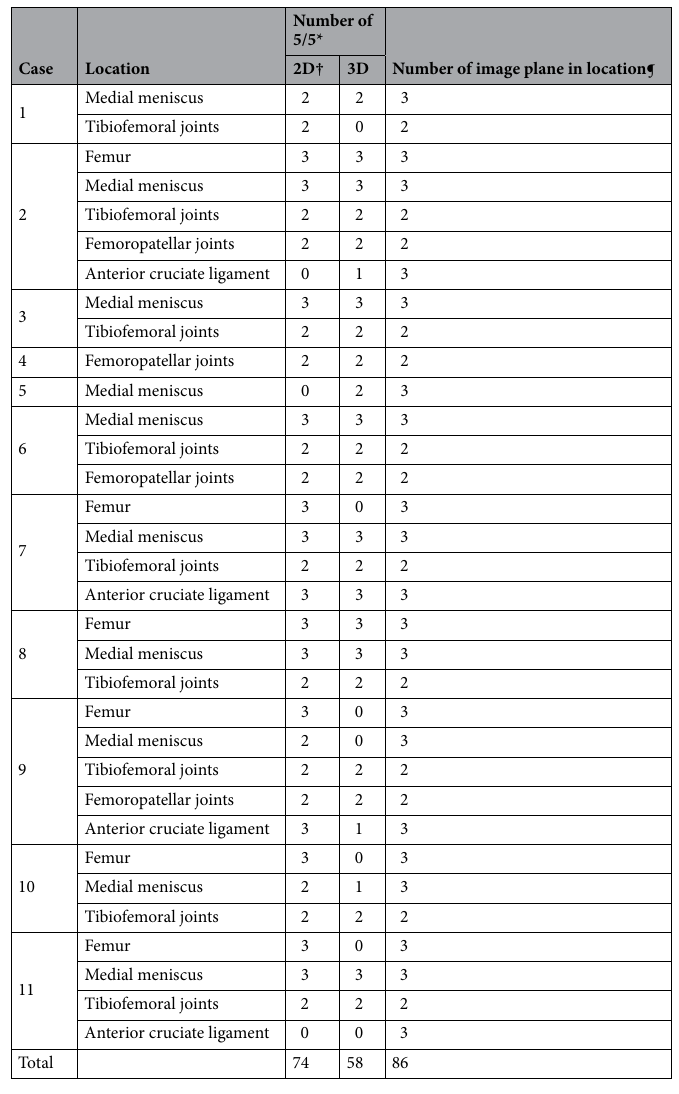
Table 5. Agreement with high confidence in “abnormal finding”. "Abnormal findings" were defined as "on both thin-slice 2D FS-PDWI and 3D FS-PD MPV images", " on two or more image planes (coronal image only for medial and lateral collateral ligament)", and “scored 4 or higher by two readers”. *5/5 indicates that two readers gave a score of 5. ¶ This represents the number of image plane defined to evaluate the abnormal findings of each location, as described in Qualitative image evaluation methods . † p value < 0.05 by the chi-squared